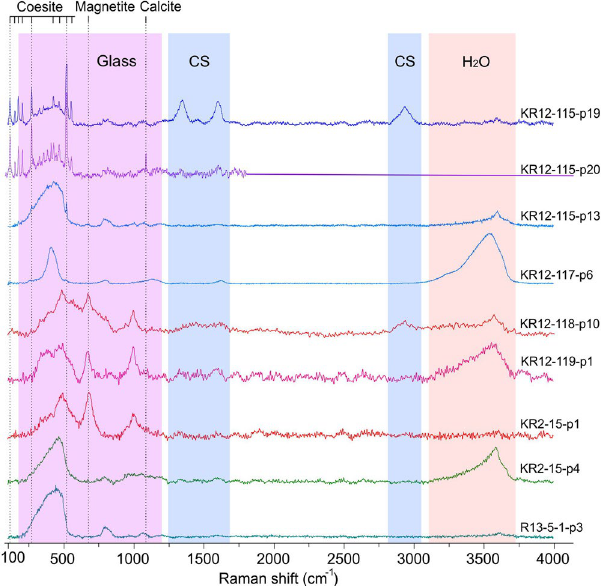
Figure 5. Raman spectra of impact glasses from the Kara astrobleme (KR) and the Ries crater (R). The color marked fields correspond to spectral ranges of glass, carbon and water. Color marked fields – regions of glass (Glass), carbon substance (CS) and H 2 O